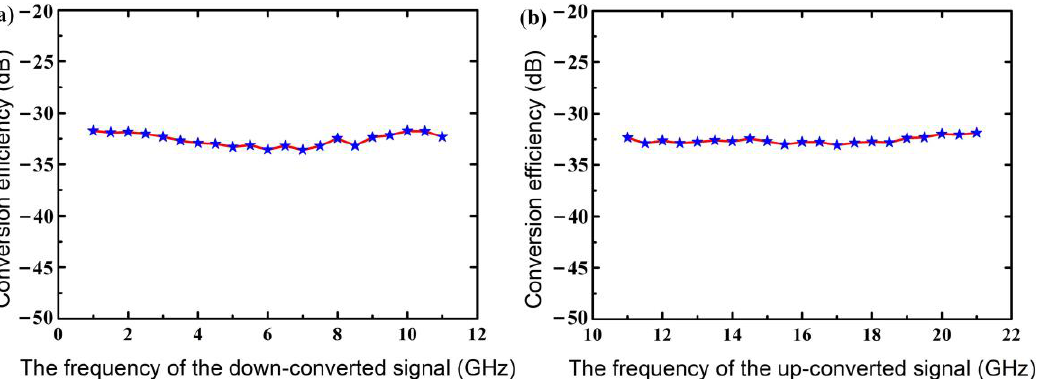
Figure 2. Measurement results for converting a single-tone IF signal at 5 GHz to 22 GHz and 32 GHz by using an LO signal at 27 GHz. ( a ) Optical spectrum from the DP-DPMZM. ( b ) Electrical spectrum of the output signal after frequency mixing.